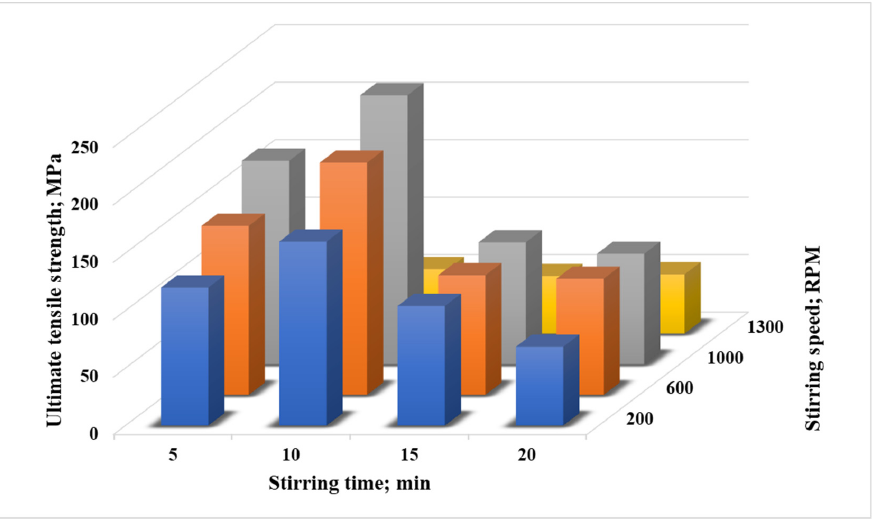
Figure 4. Ultimate tensile strength values for Al6061/TiO 2 (2 wt.%) stirred at different speeds and duration times.